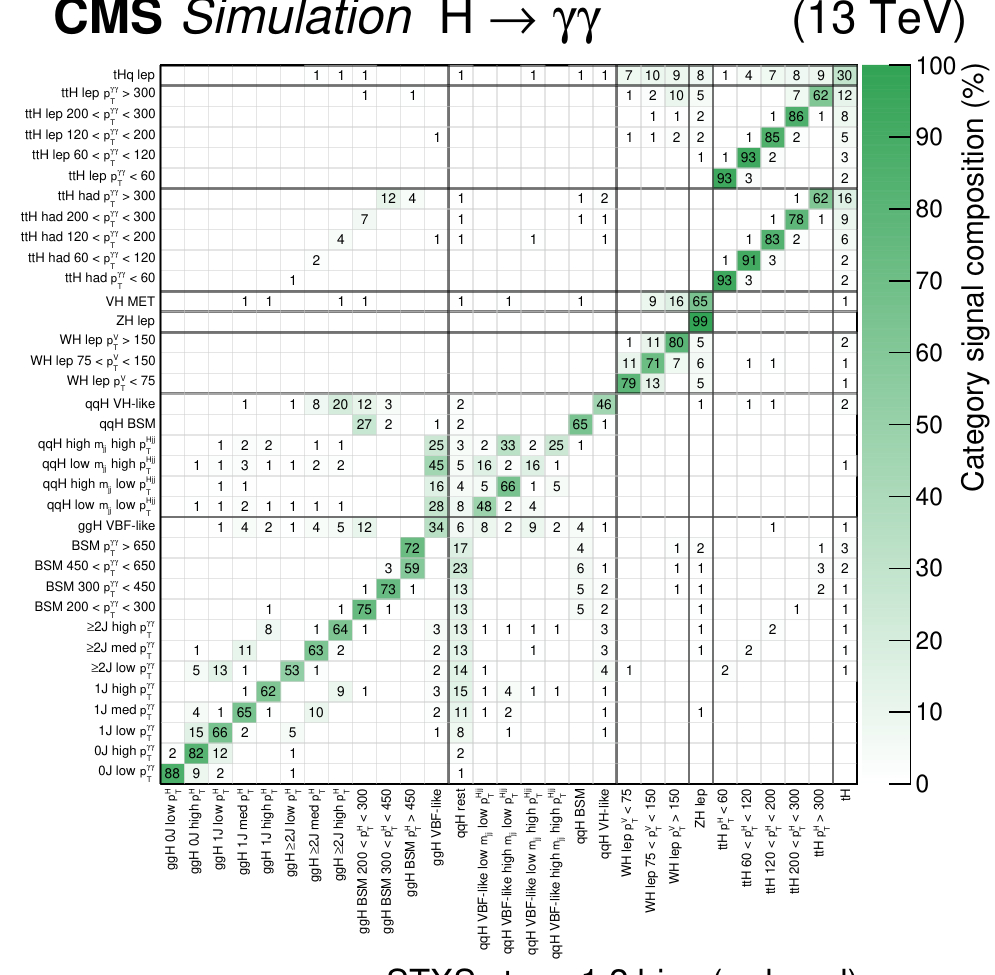
Figure 13 . The composition of the analysis categories in terms of a merged set of STXS bins is shown. The granularity of the STXS bin merging corresponds to the finest granularity used for the cross section measurements in this analysis. Analysis categories targeting a common STXS region are summed, where the signal compositions of the individual categories are weighted in the sum by the expected ratio of signal to signal-plus-background events. The colour scale corresponds to the fractional yield in each analysis category group (rows) accounted for by each STXS process (columns). Each row therefore sums to 100%. Entries with values less than 0.5% are not shown. Simulated events for each year in the period 2016–2018 are combined with appropriate weights corresponding to their relative integrated luminosity in data. The column labelled as “qqH rest” includes contributions from the qqH 0J, qqH 1J, qqH m < 60 GeV and qqH 120 < m < 350 GeV jj jj STXS